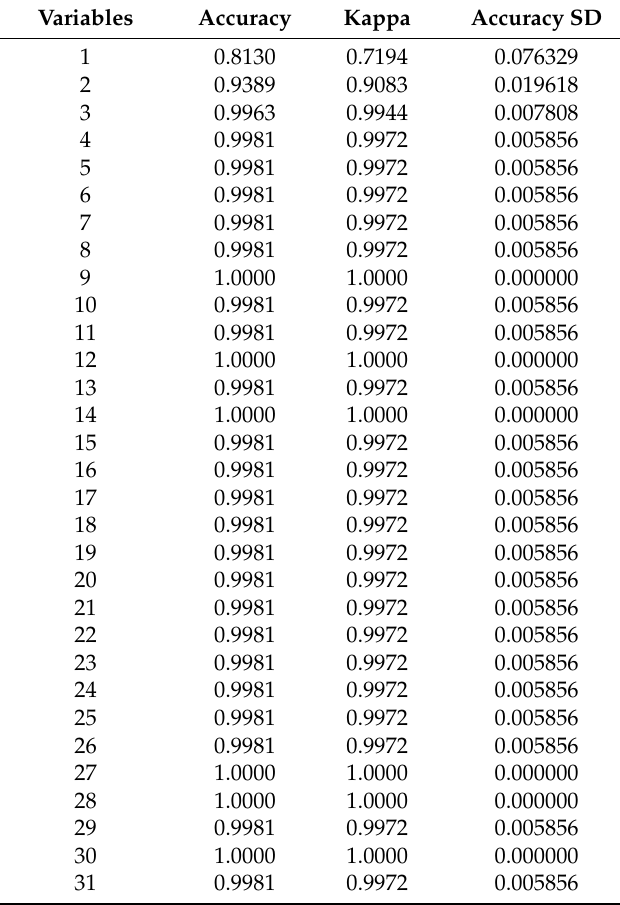
Table 4. Resampling performance over a subset